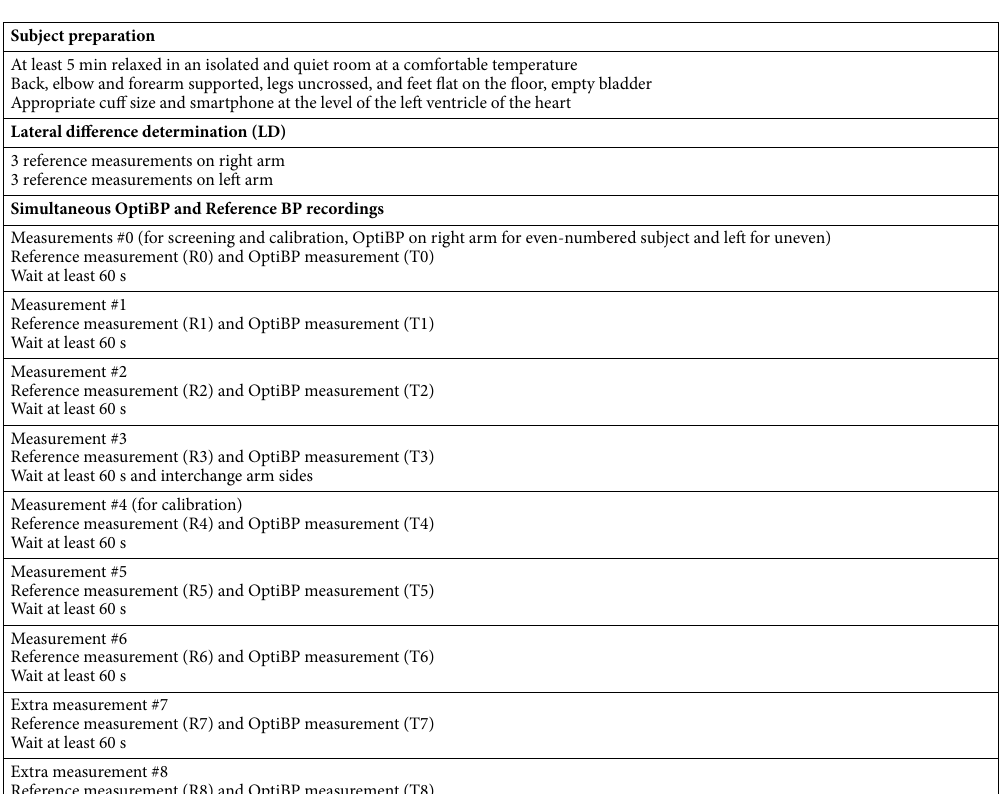
Table 1. Study protocol for patients included in the validation set. R reference measurement, T tested device measurement (OptiBP).